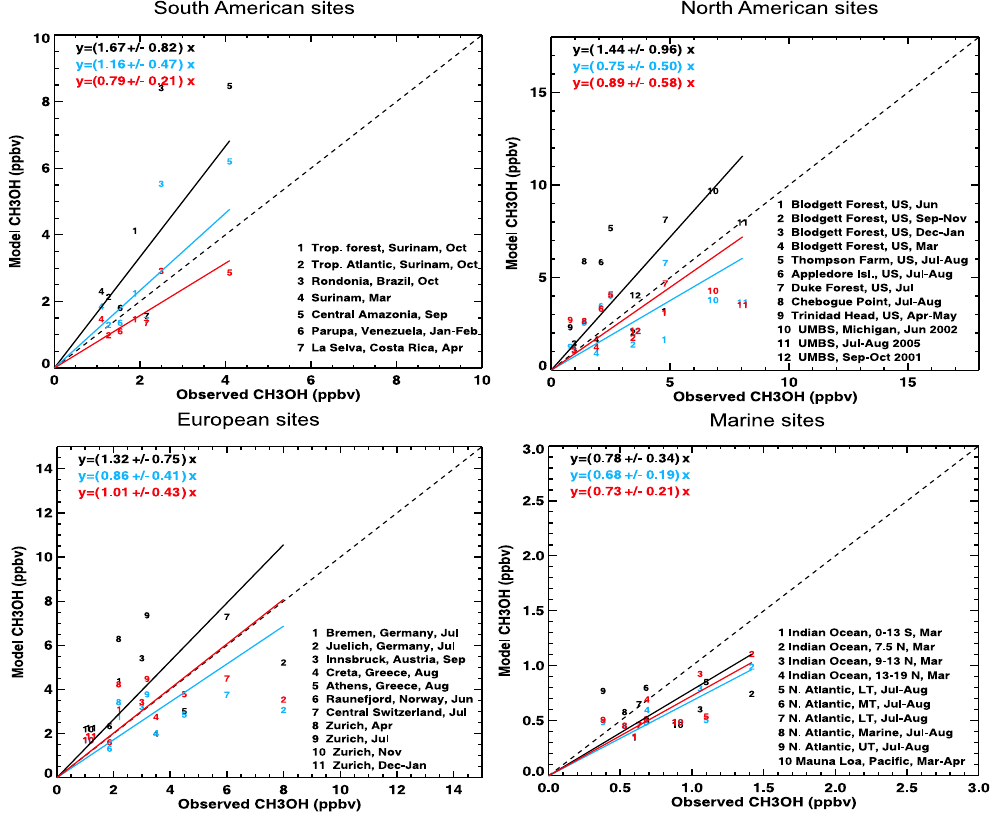
Fig. 9. In situ measurements of methanol concentrations shown on Table 5 are compared with the predicted concentrations from simulations S1 (in black), S2 (in blue) and OptS2 (in red). For each simulation, the slopes of the regression lines passing through the origin as well as their standard deviations are illustrated inset respecting the same color code.